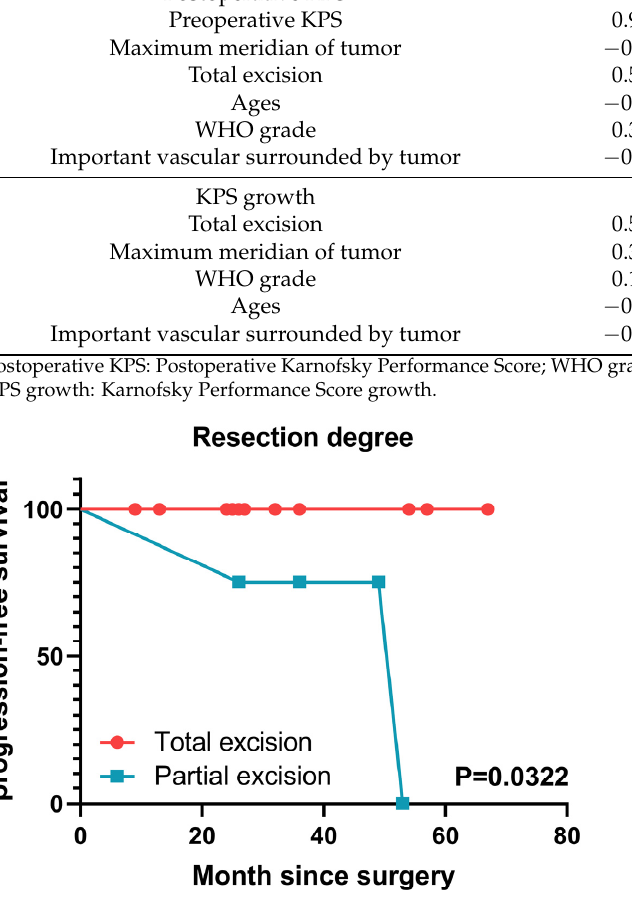
Figure 5. Kaplan–Meier survival analysis of 15 patients, the score on the y-axis refers to the non- recurrence rate of the patient. Patients with total resection of chondrosarcoma had longer progression-free survival than patients with partial resection ( p = 0.0322).